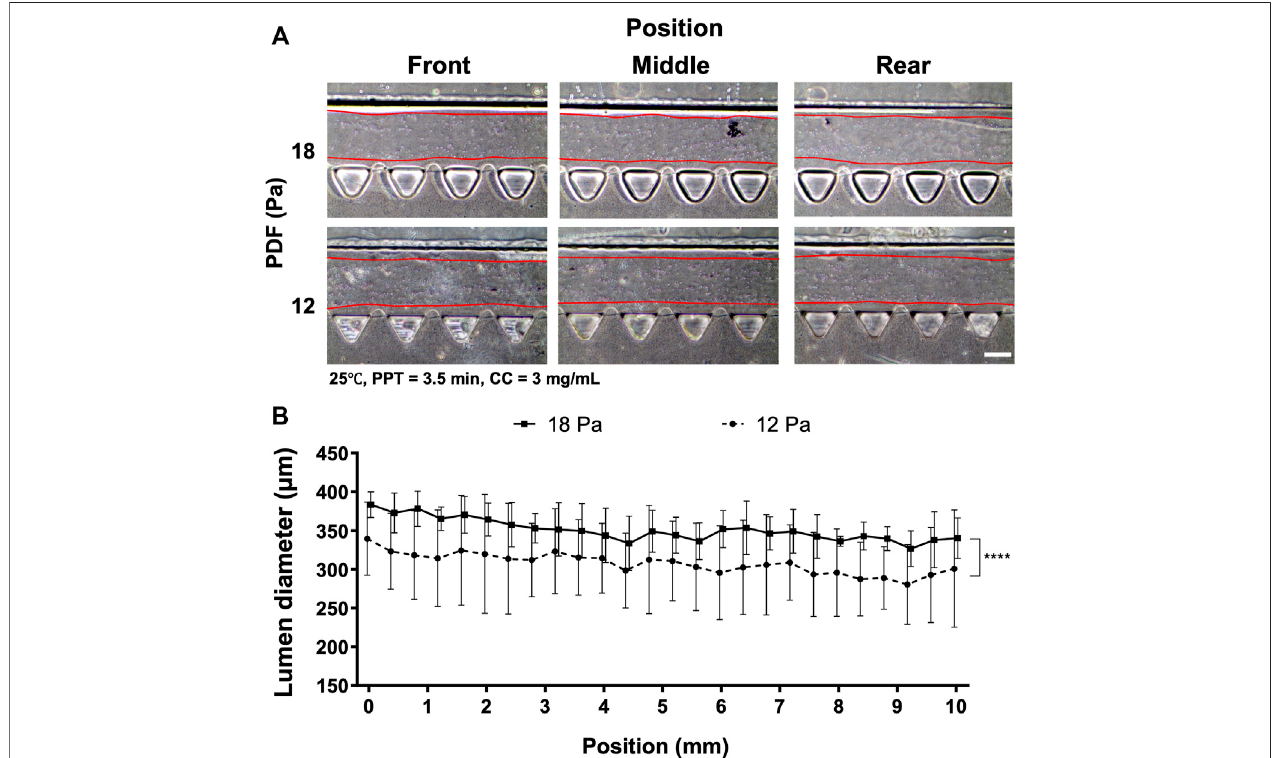
FIGURE 4 | Comparison of the collagen lumen formed at different PDF values of 18 and 12 Pa, where the temperature was set at RT, PPT at 3.5 min and CC at 3 mg ml − 1 . (A) Morphologyofthecollagenlumenformedatdifferentlocationsofthemediachannel. (B) Quanti fi cationoftheaveragecollagenlumendiameteratdifferent locations in the media channel polymerized at PDFs of 18 and 12 Pa. Scale bar: 200